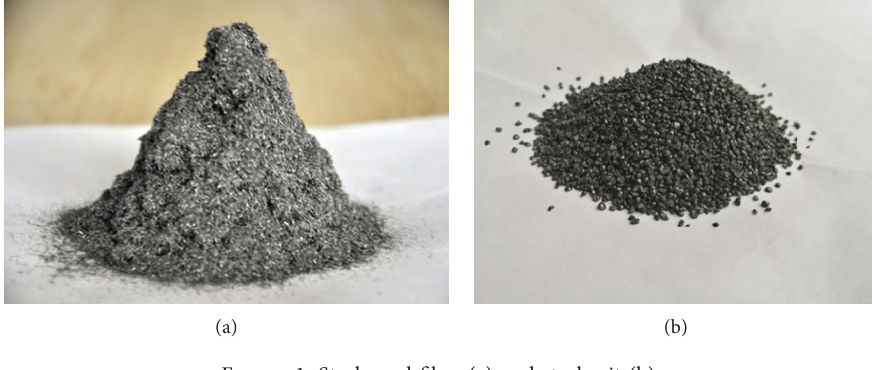
Figure 1: Steel wool fiber (a) and steel grit (b). Table 1: The properties of asphalt, steel wool fiber, and steel grit.